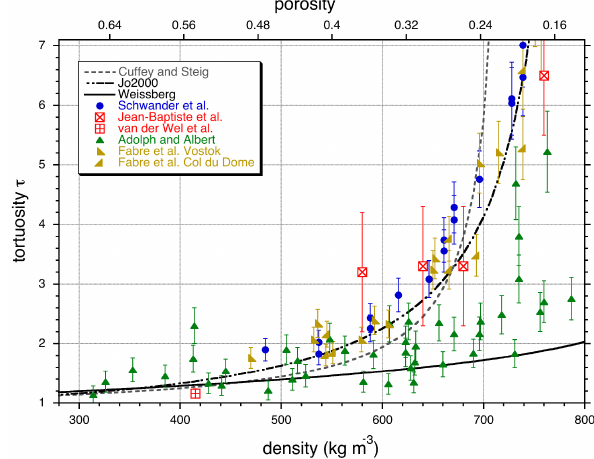
Figure 9. Results of various tortuosity measurements from the liter- ature, with τ defined according to our Eq. (13). The symbols are the results of the various measurements: the red squares are laboratory firn diffusion measurements (by Jean-Baptiste et al., 1998, and van der Wel et al., 2011a); the blue circles CO 2 and O 2 gas diffusion measurements through firn from Siple dome, Antarctica (Schwan- der et al., 1988); and the green triangles SF 6 gas diffusion measure- ments through firn from Summit (Adolph and Albert, 2013, 2014). Finally pale brown triangles are the results by Fabre et al. (2000) for SF 6 gas diffusion in Vostok and Col du Dome. The black dash- dotted line is the parameterization for the Schwander et al. (1988) data in the Johnsen et al. (2000) model. The grey dashed curve is the tortuosity that is equivalent to the fit that Cuffey and Steig (1998) made to isotope seasonal cycles in the Summit firn layer. Further- more, as a lower limit, we have included the theoretical result, in- terpreted as τ , by Weissberg (1963), which he derived for spheres that can partly overlap or even fuse. For discussion of the results, see